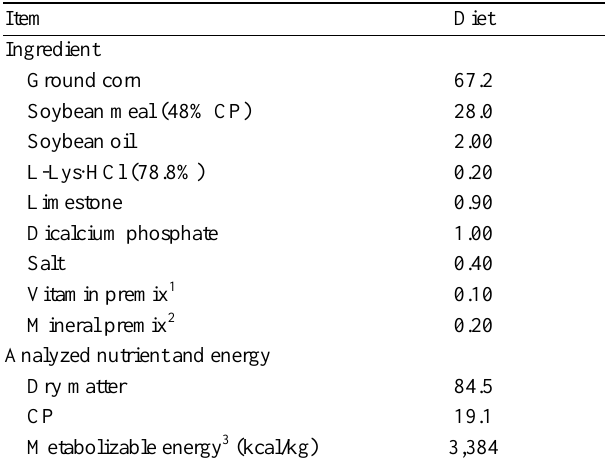
Table 3. Ingredient and nutrient composition (%) of recovery diet (as-fed basis), Exp.